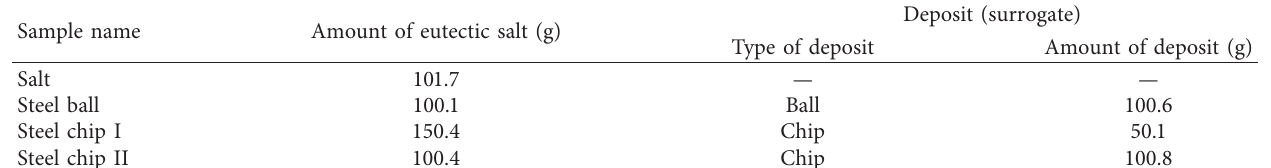
Table 1: Types of samples used for the investigation of the type effect.